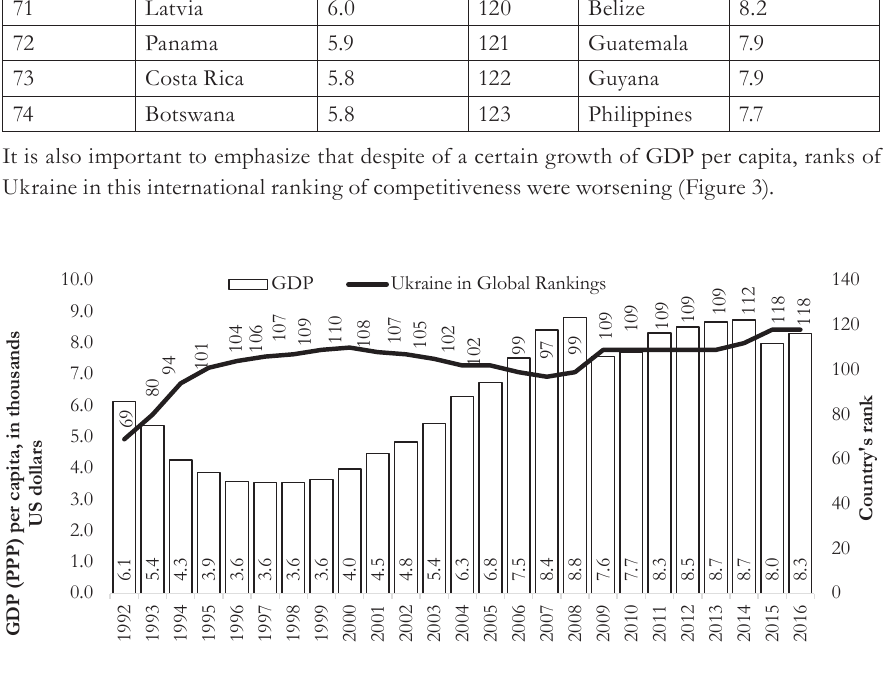
Fig. 3 – Assessments of economic development of Ukraine in 1992-2016. Source: IMF